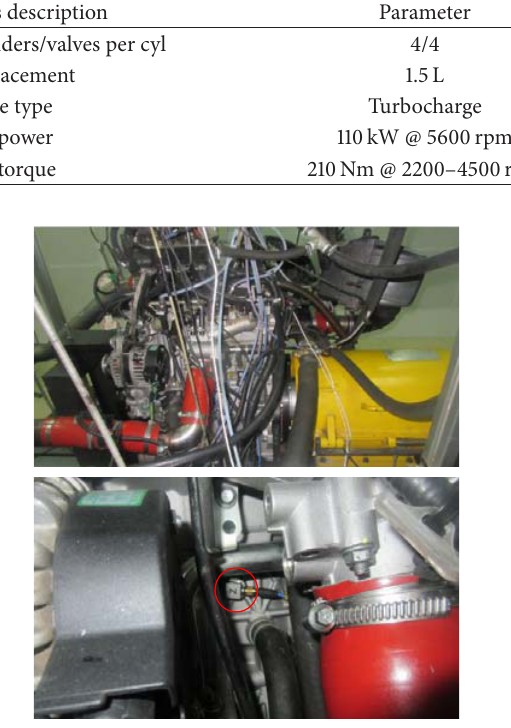
Figure 6: The locations of the vibration acceleration sensors on the test